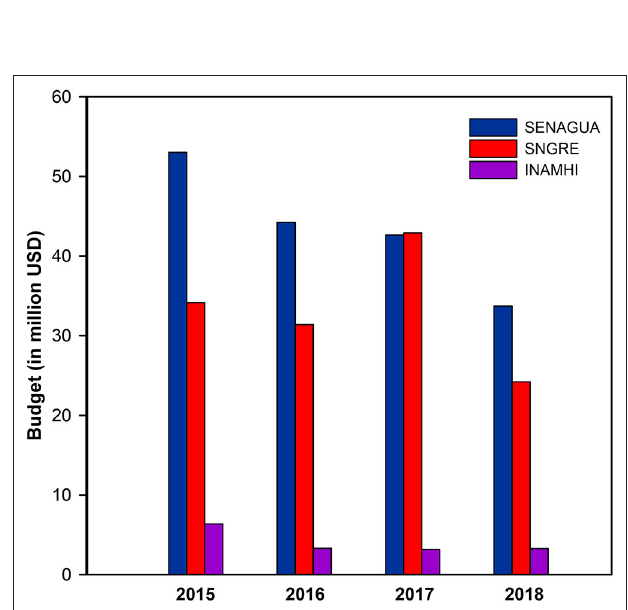
FIGURE 2 | Examples of recent riverine flooding in the Ecuadorian highlands: (A) Flood discharge of the San Francisco River (a tributary of the Santa Bárbara River) (in May 2019), (B) Gualaceo flooded by the Santa Bárbara River (in July 2017). Images courtesy of EMAPAS-G EP (left) and Municipality of Gualaceo (right).